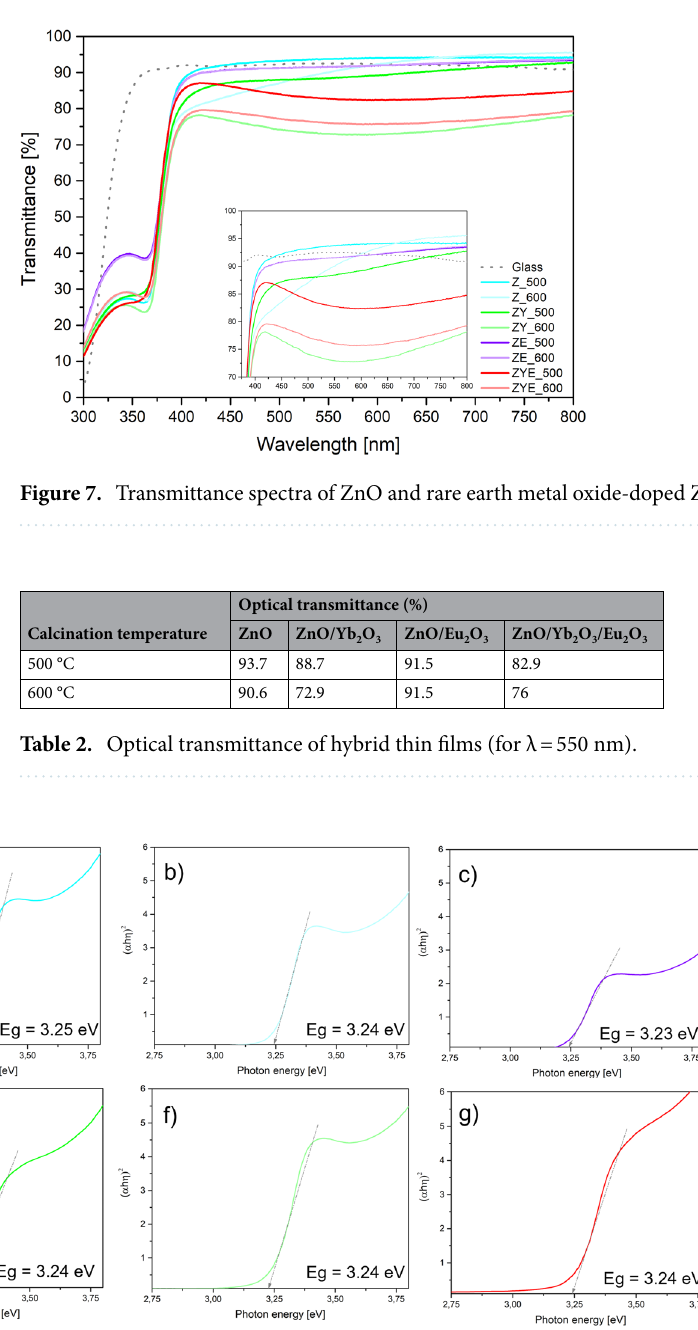
Figure 8. Dependence of (α h υ) 2 as a function of photon energy with a linear relationship for α = 0 and the determined values of the optical energy gap of thin hybrid